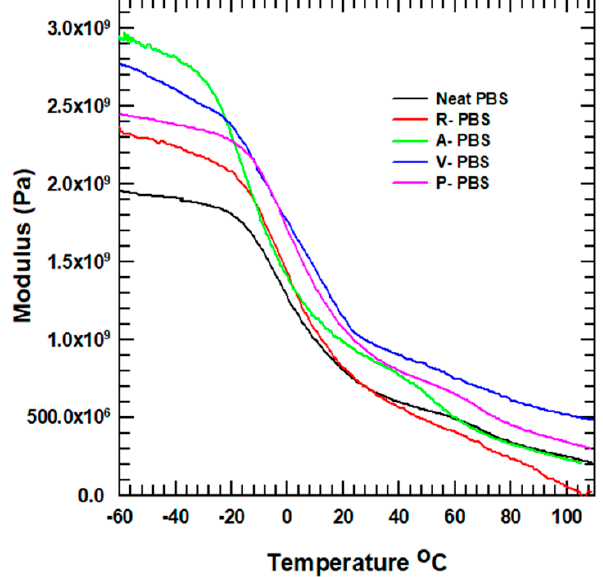
Figure 9. Storage modulus of the neat PBS and its composite.